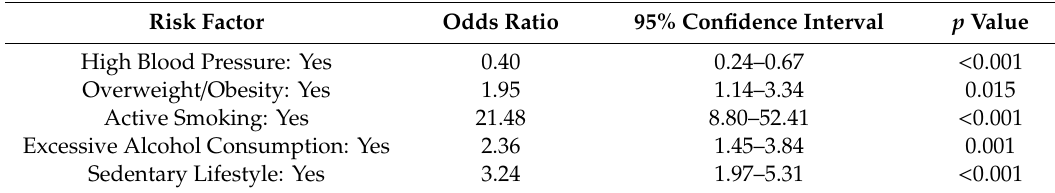
Table 3. Multivariate regression analysis of predictive risk factors (RFs) for having an acute stroke in patients aged 75 years or